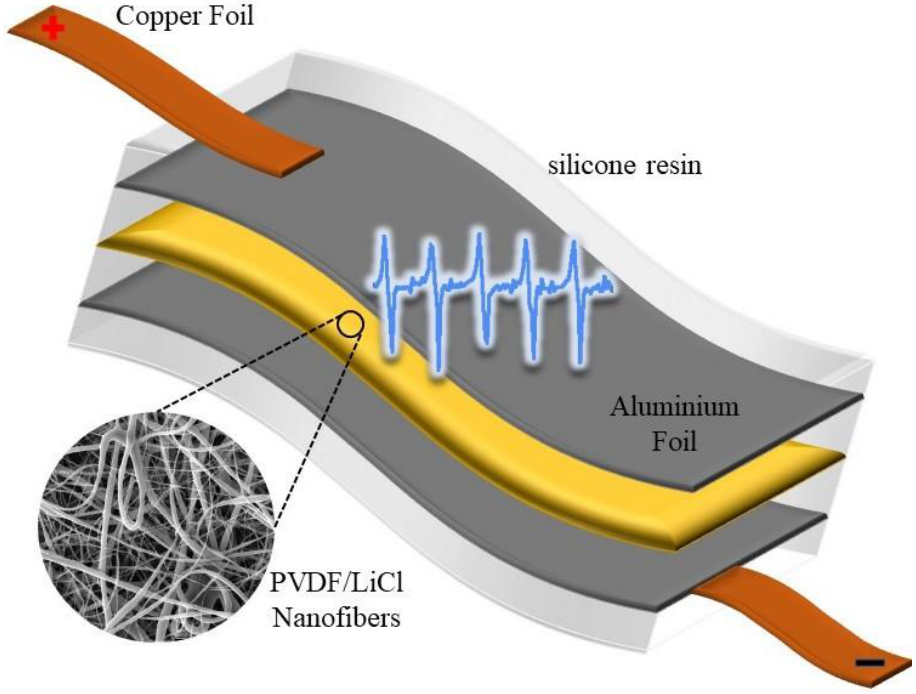
Figure 1. Schematic structure of the polyvinyledene fluoride (PVDF)/LiCl nanogenerator device.